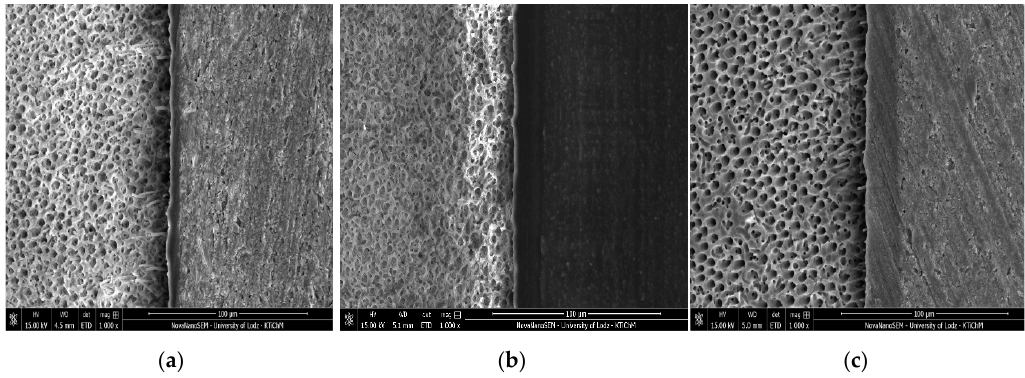
Figure 4. SEM images of adhesive layers obtained by application of Prime&Bond One Select: ( a ) one layer; ( b ) two layers; ( c ) three layers; mag. 1000x.